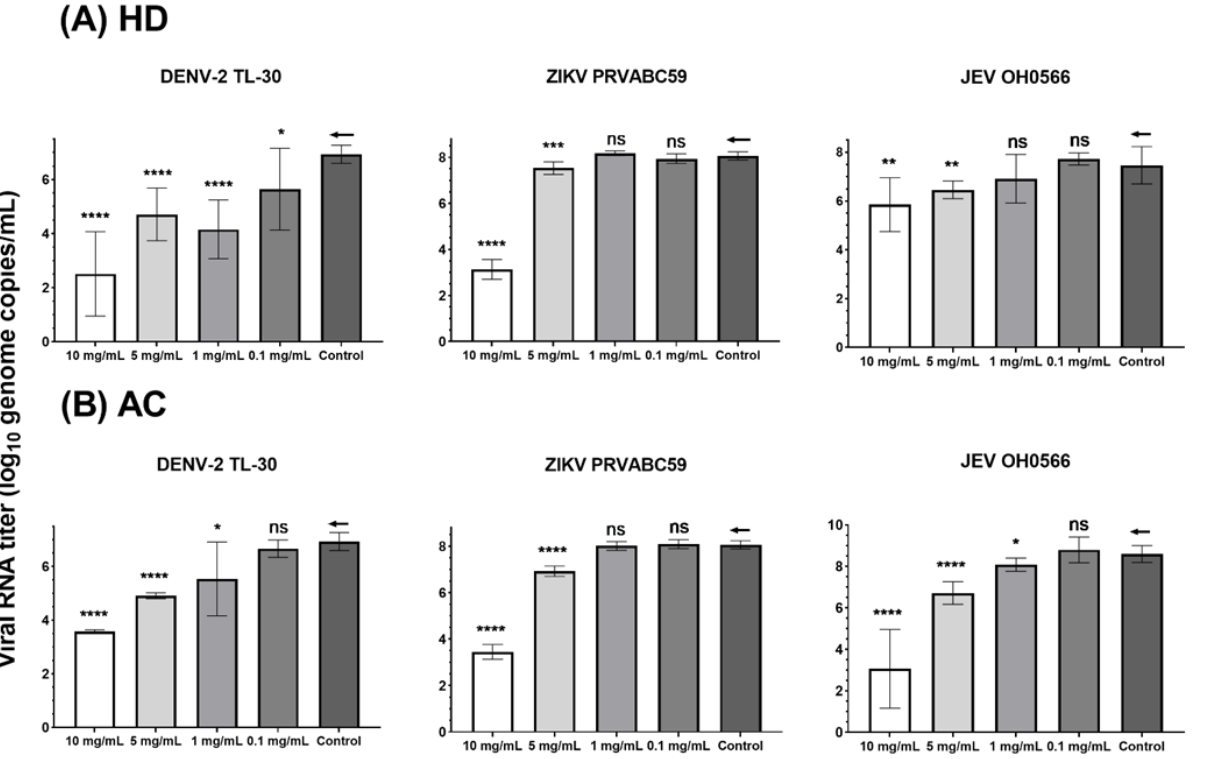
Figure 3. Viral genomic RNA levels of DENV-2 TL-30, ZIKV PRVABC59, and JEV OH0566 treated with Hedyotis diffusa (HD) and Artemisia capillaris (AC) in Vero 9013 cells as determined by RT-qPCR. Supernatants were collected to determine extracellular viral load at 72 h p.i. for JEV OH0566 and ZIKV PRVABC59 and 96 h p.i. for DENV-2 TL-30, respectively. The viral RNA levels were quantified by RT-qPCR as log 10 viral genome copies/mL. ( A ) viral RNA level analysis following HD treatment. ( B ) Inhibition in AC treated samples. The error bars represented the standard deviation of the mean of octuplicate (8 copies); ← : control; * p < 0.05; ** p < 0.01; *** p < 0.001; **** p < 0.0001; and ns